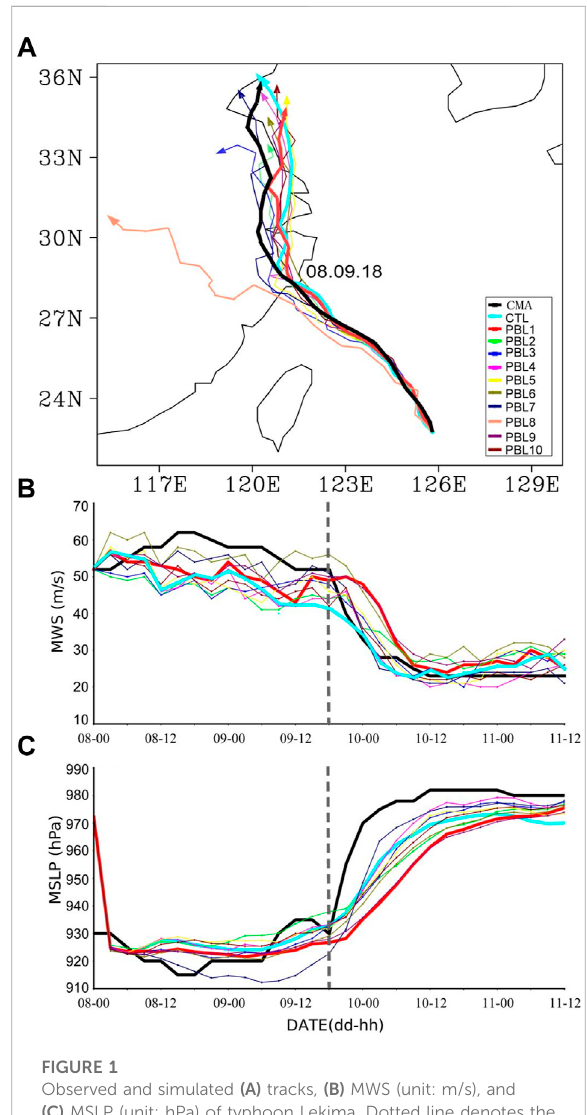
FIGURE 1 Observed and simulated (A) tracks, (B) MWS (unit: m/s), and (C) MSLP (unit: hPa) of typhoon Lekima. Dotted line denotes the observed landing